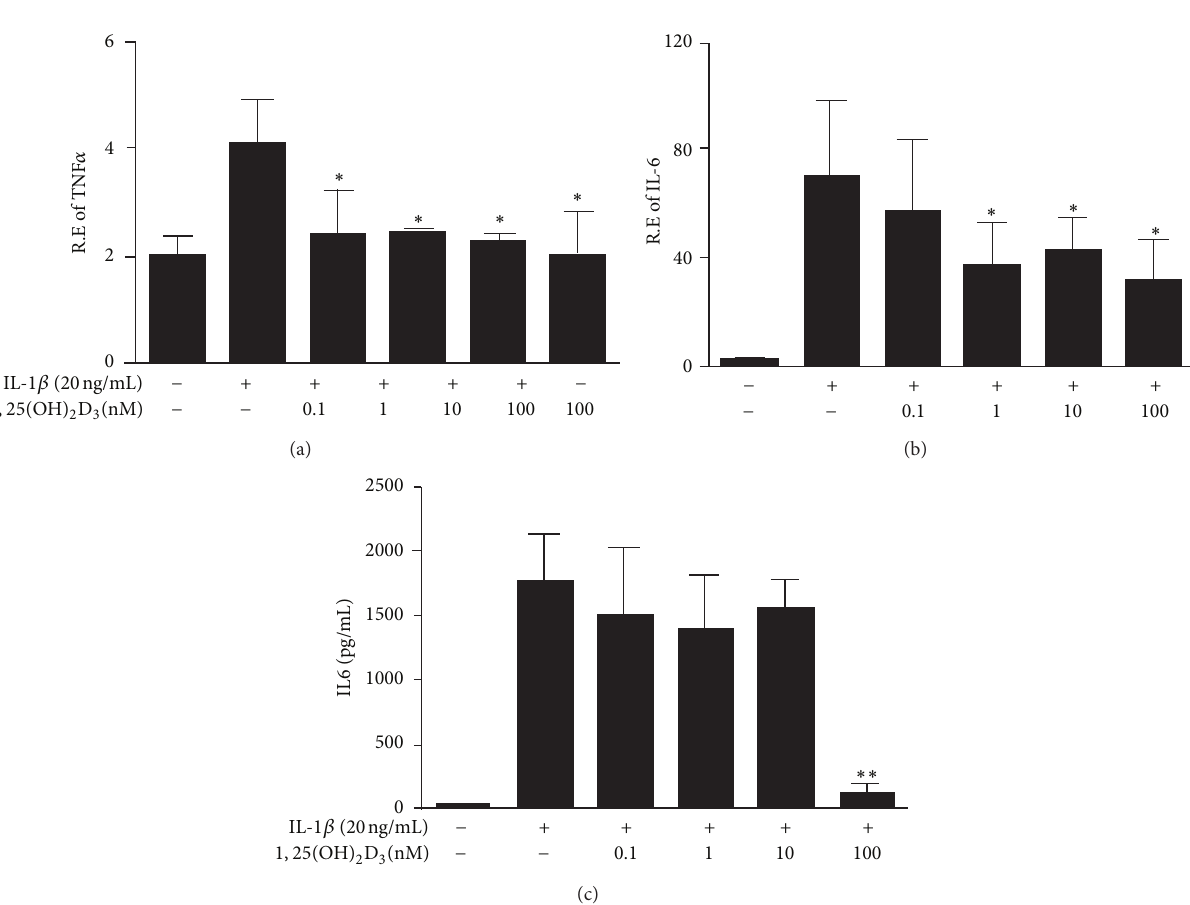
IL-1 𝛽 for 48 hours (Figures 4(a)–4(c)). However, transcript levels of TNF 𝛼 (Figure 4(a)) and IL-6 (Figure 4(b)) in IL-1 𝛽 - with 1,25(OH) 2 D 3 at the dosage of 0.1 to 100 nM and 1